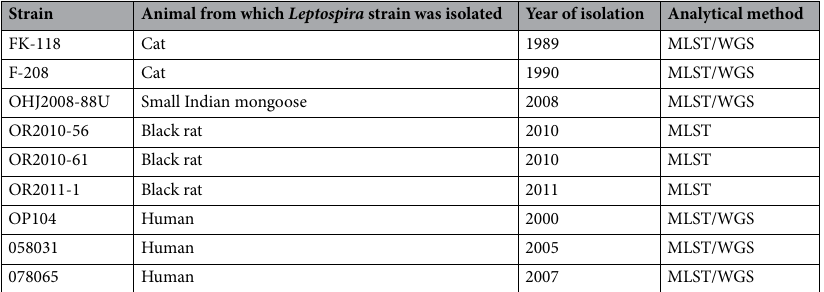
Table 2. L. borgpetersenii serogroup Javanica strains used for MLST and/or WGS. MLST, multilocus sequence typing; WGS, whole genome sequencing.